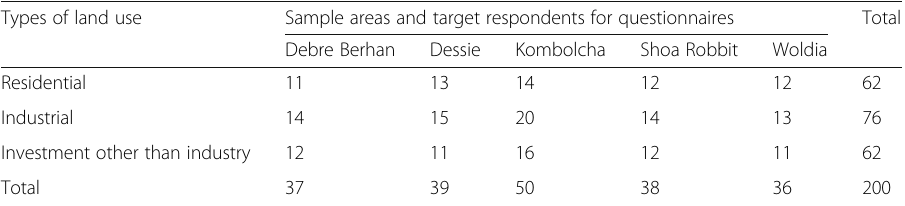
Table 2 Sample framework of target population to distribute questionnaires Types of land use Sample areas and target respondents for